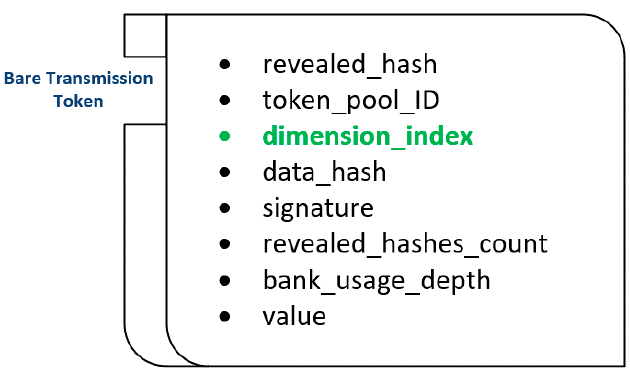
Figure 15. Very low overhead compared to original Transmission Figure 15 . Very low overhead compared to original Transmission Token.